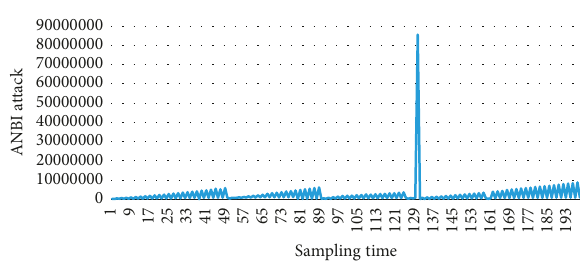
Figure 10: Feature of ANPI for normal traffics.